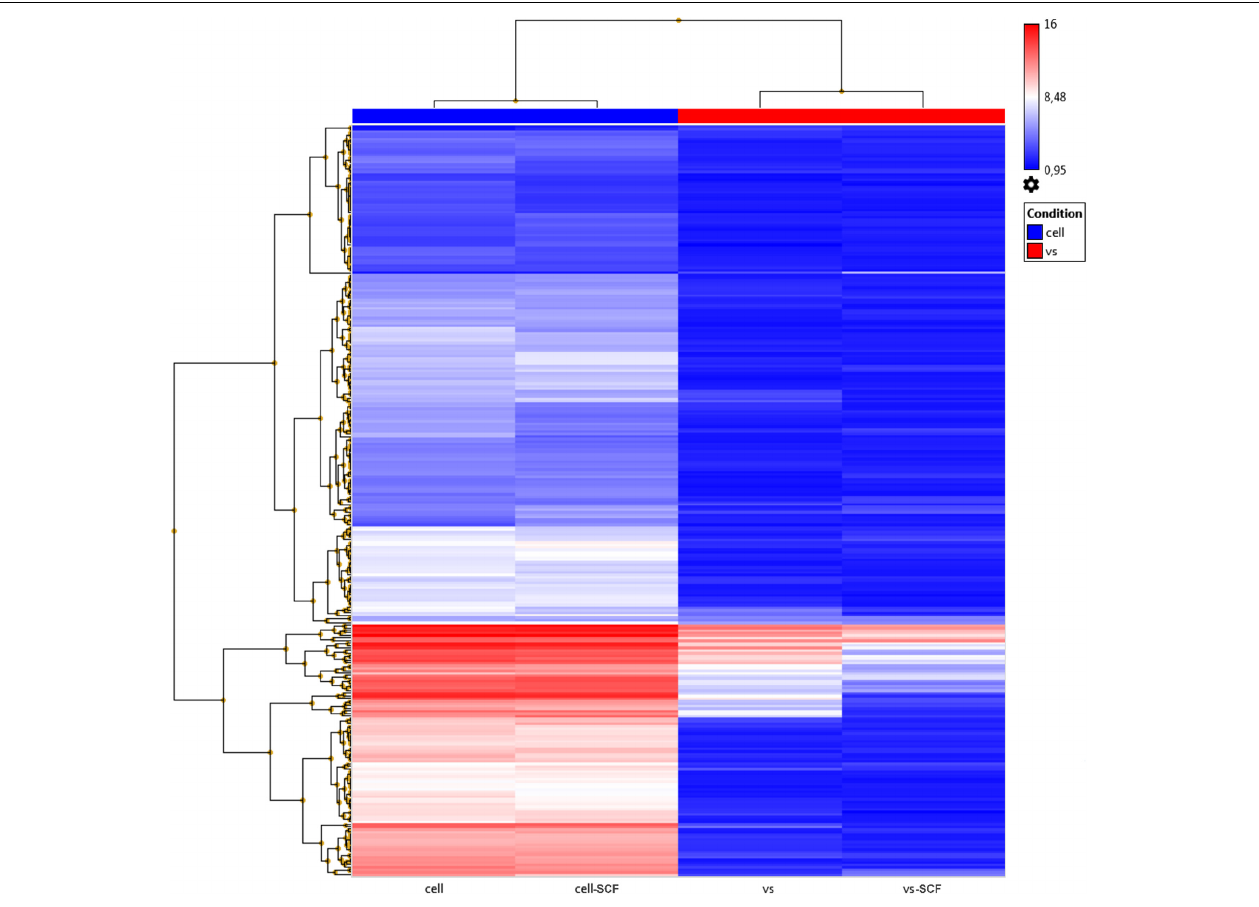
FIGURE 2 | Hierarchical clustering dendrograms of differentially expressed miRNA expression patterns in EVs and cell samples obtained by the GeneChipTM miRNA Arrays